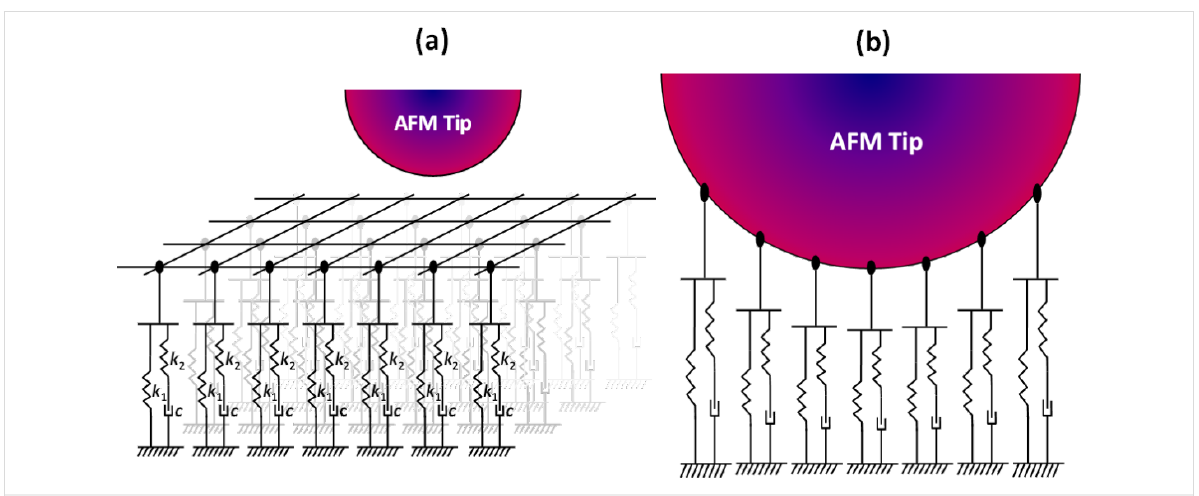
Figure 2: (a) Illustration of AFM tip approaching a 2-dimensional array of SLS models; (b) illustration of AFM tip interacting only with the SLS models directly below it, and interacting to a different depth with each element, as dictated by its geometry. Each SLS model in (a) and (b) is of the same form as the one shown in Figure 1a.